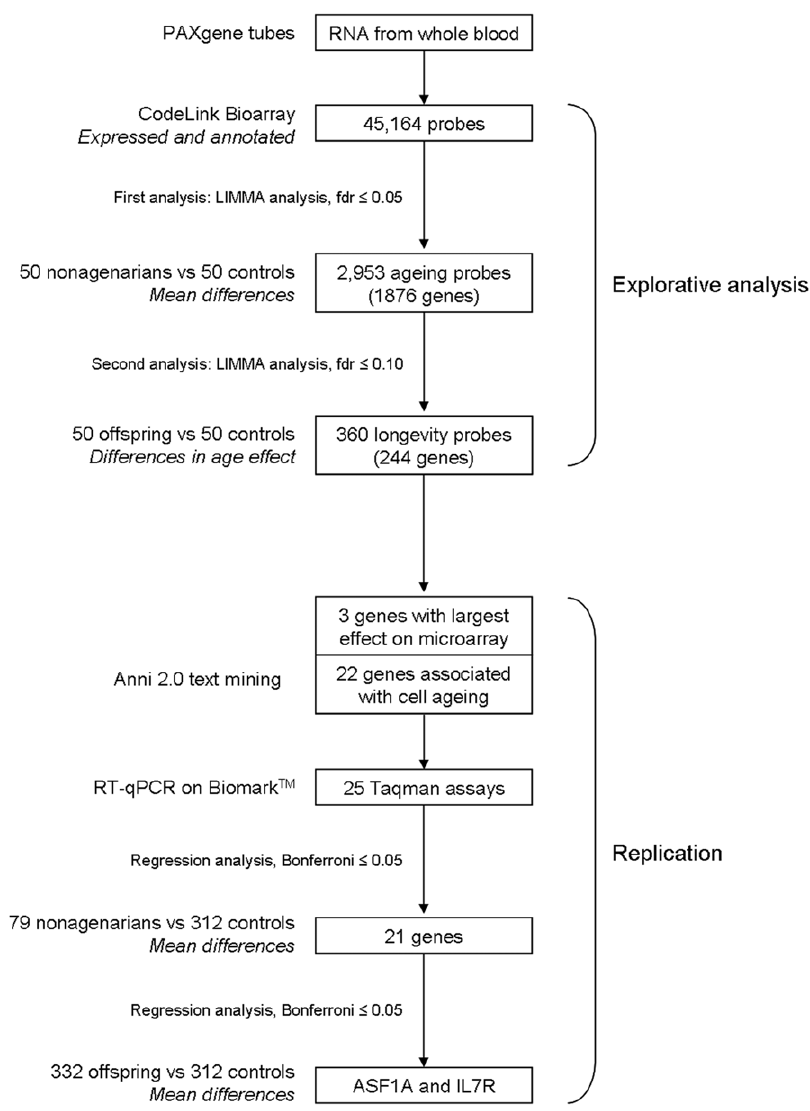
Figure 1. Flowchart of gene expression analyses. The order of analyses is shown for the explorative analysis (top half of the figure) and the replication analysis (bottom half of the figure). The probes/genes are depicted in the boxes and to the left thereof are the techniques or analyses used.